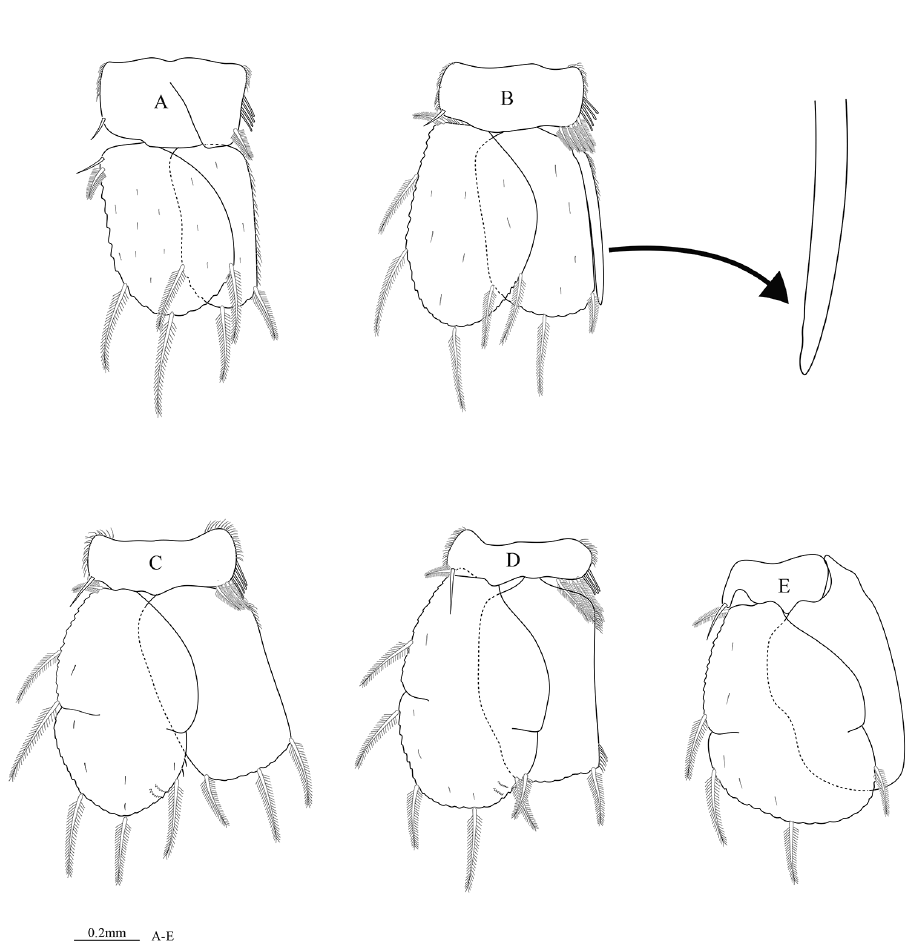
Figure 5. Cirolana phuketensis sp. n., male paratype (PSUZC–CR0286-02) (5.1 mm) ( A–E ) pleopods 1–5